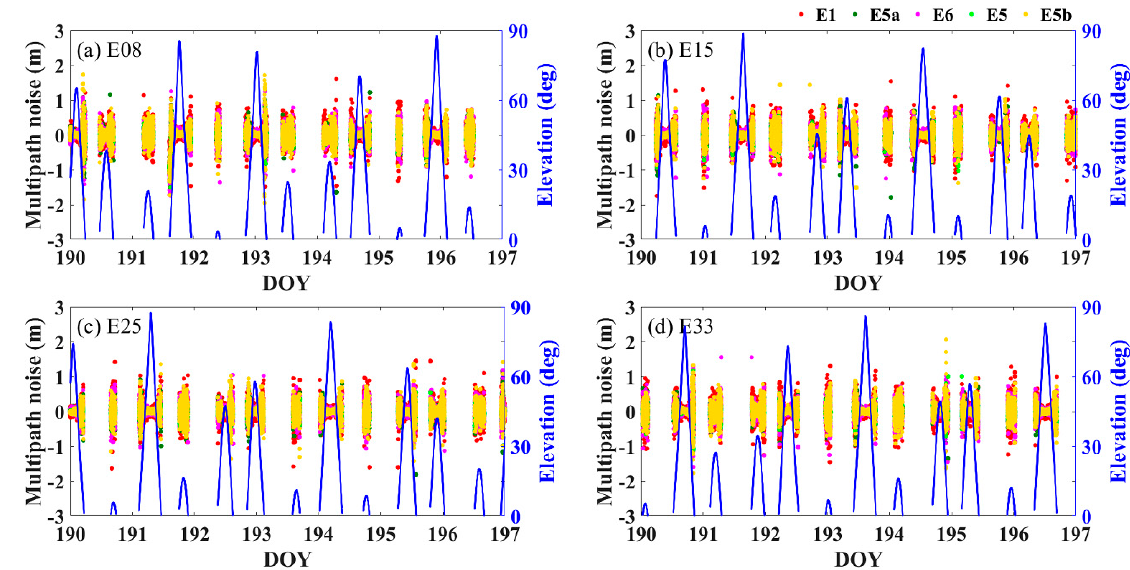
Figure 4. Galileo multipath combination noise sequence and elevation at frequencies E1, E5a, E6, E5 and E5b at BRUX station on DOYs 190 to 196 in 2020. ( a ) E08 satellite; ( b ) E15 satellite; ( c ) E25 satellite; and ( d ) E33 satellite.